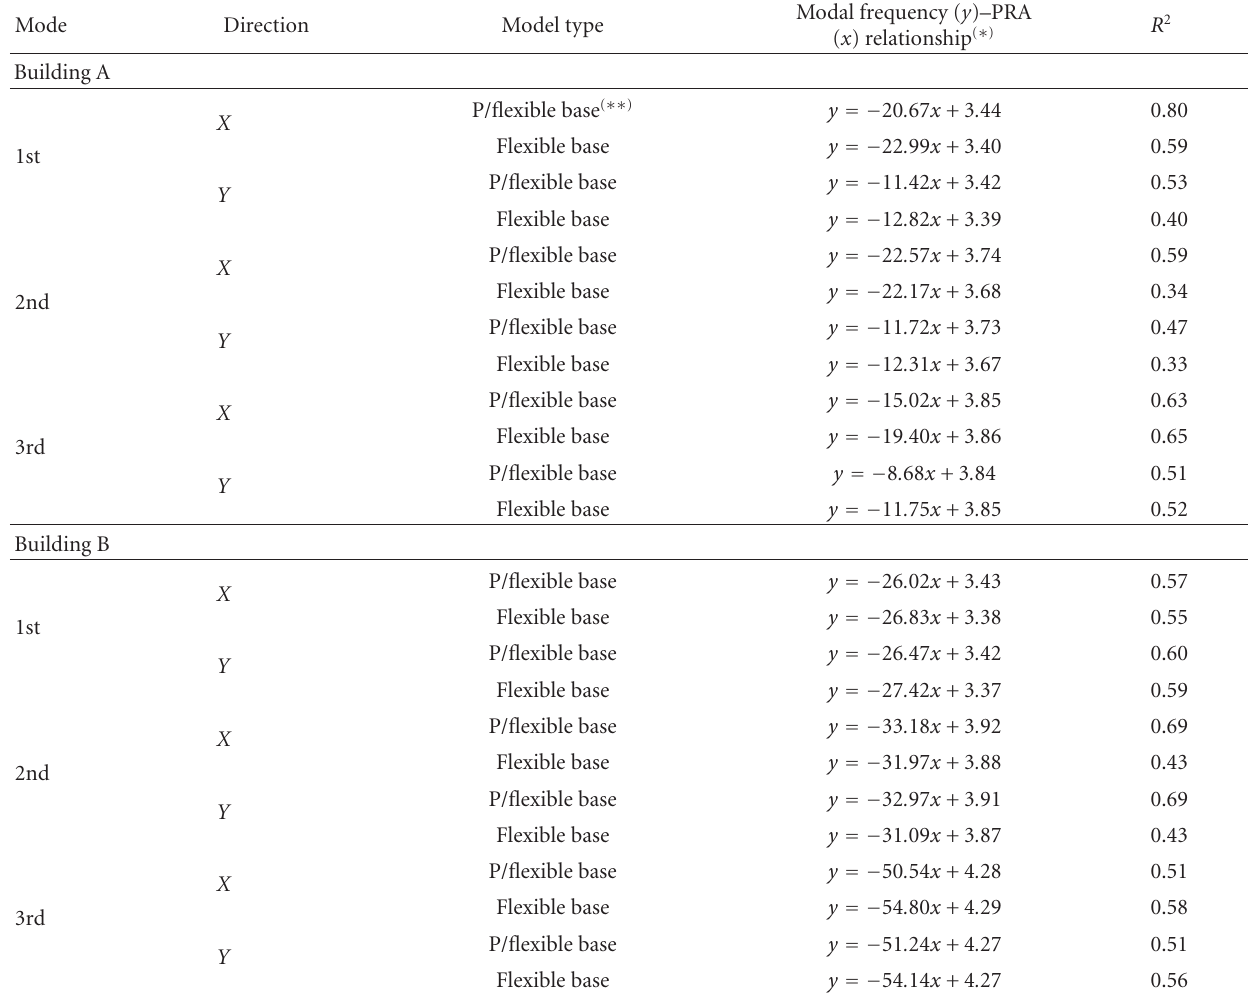
Table 5: Dependence of modal frequencies on PRA.